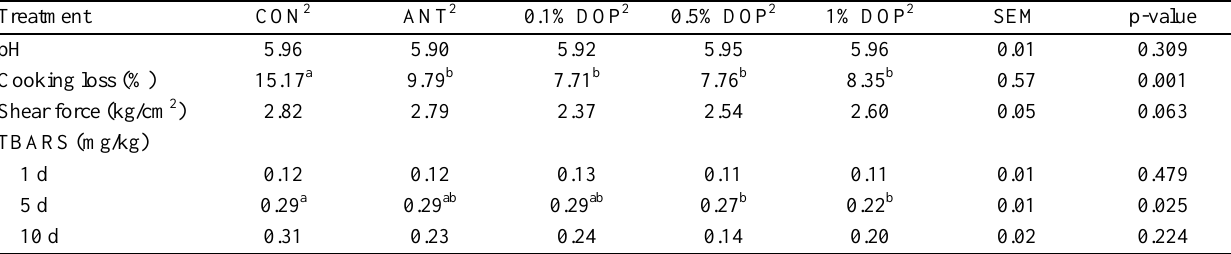
Table 7. Effect of dietary dried oregano powder (DOP) supplementation on meat quality in meat ducks 1 Treatment